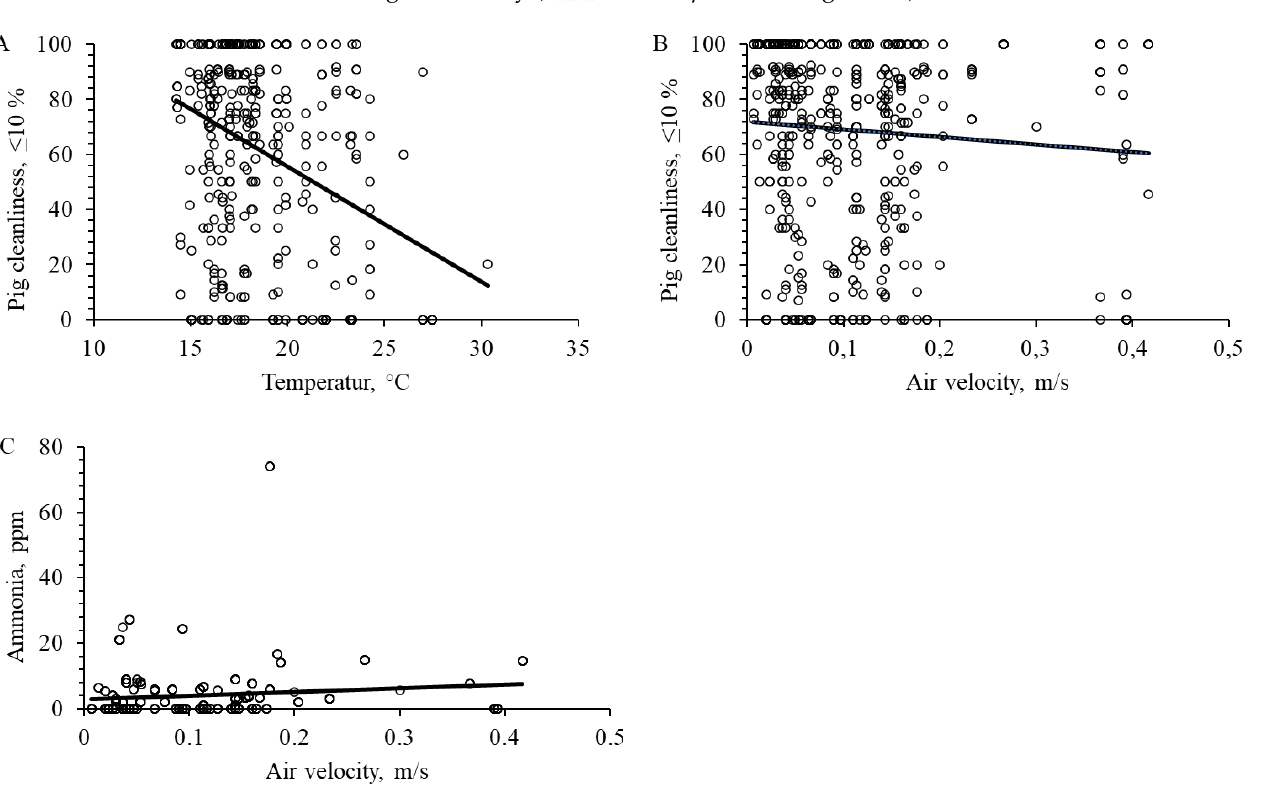
Figure 5. Effect of ambient temperature and air velocity on pen and pig cleanliness, and ammonia concentration. ( A ) Pig cleanliness and temperature (F 1472 = 28.9; p < 0.001). ( B ) Pig cleanliness and air concentration. ( A ) Pig cleanliness and temperature (F 1,472 = 28.9; p < 0.001). ( B ) Pig cleanliness and air velocity (F 1472 = 8.8; p = 0.003). ( C ) Ammonia concentration and air velocity (F 1472 = 115.2; p < velocity (F 1,472 = 8.8; p = 0.003). ( C ) Ammonia concentration and air velocity (F 1,472 = 115.2; p < 0.001).